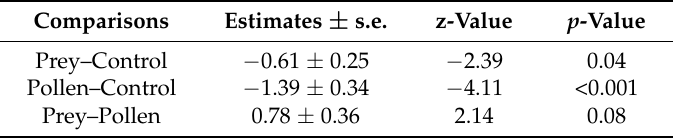
Figure 1. Rate of cannibalism (number of intraspecific prey killed per 24 h) in mullein bugs of prey- and pollen-specialized lines fed on diets without additional food (control) or with two-spotted spider mites and pollen. Letters correspond to significant differences among treatments ( α = 0.05). Table 1. All-pairwise comparisons of Tukey’s Test for Poisson GLM-compared treatments (control: no added food; prey: two-spotted spider mites; and pollen) in tests of cannibalism in mullein bug nymphs (both prey- and pollen-specialized lines were included in the model).